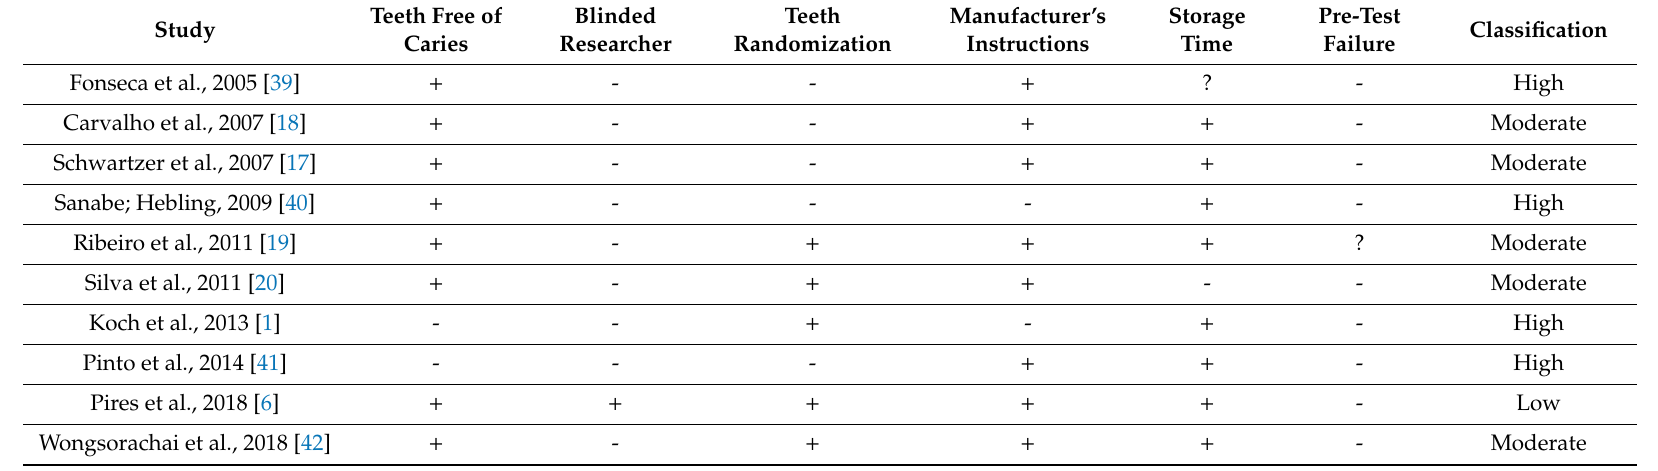
Table 2. Individual risk of bias of the included